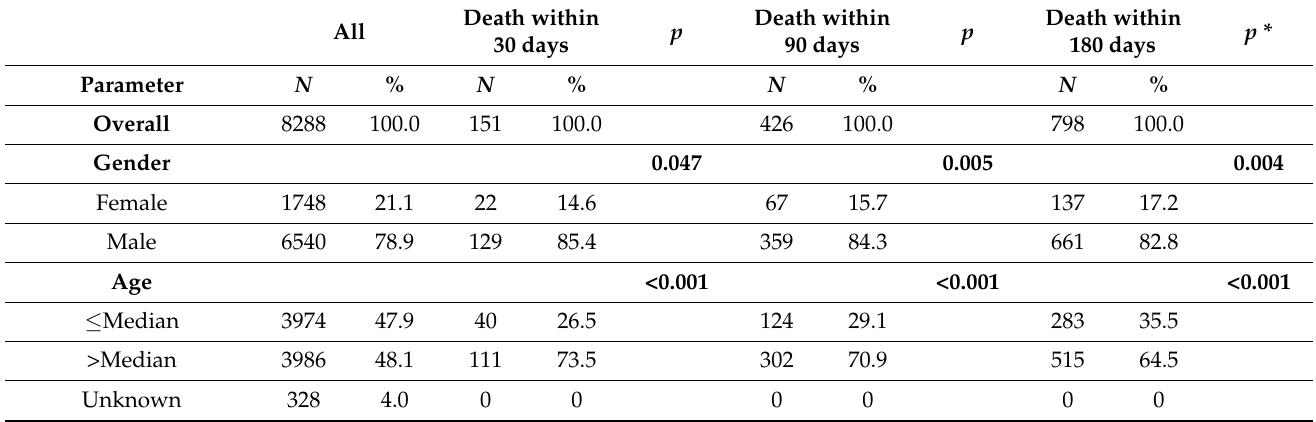
Table 1. Univariable analyses on predictors for 30-day, 90-day, and 180-day